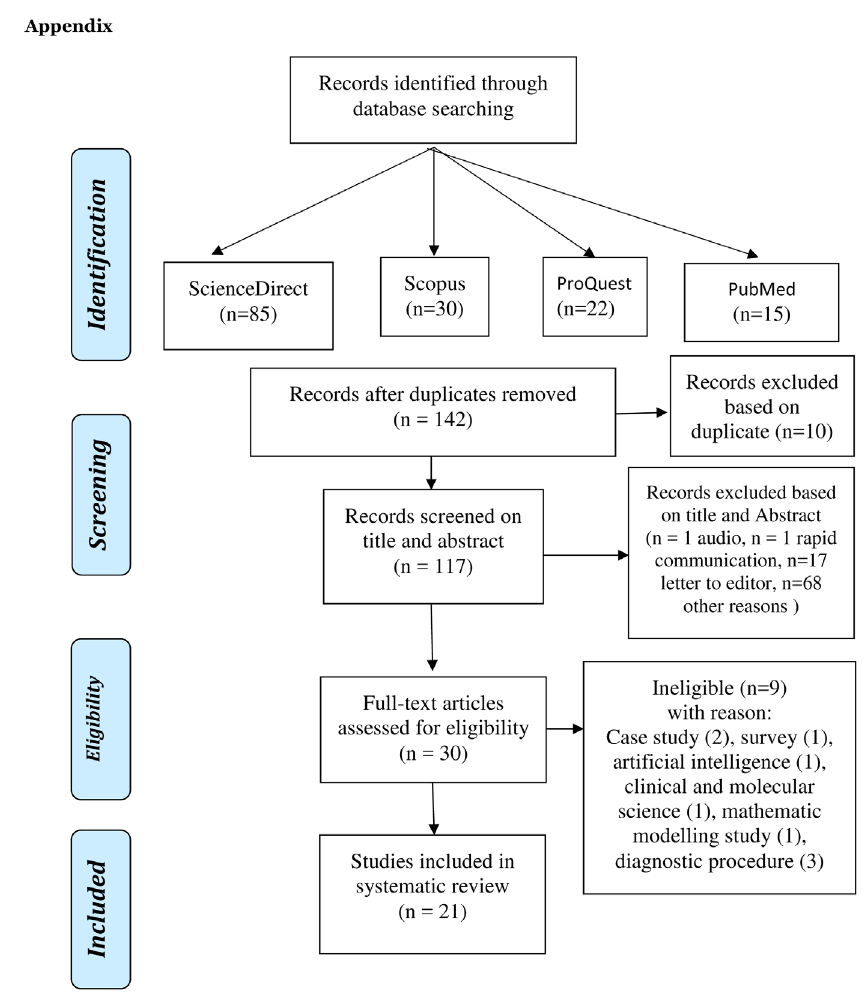
Figure 1. Flow chart of the search strategy and article